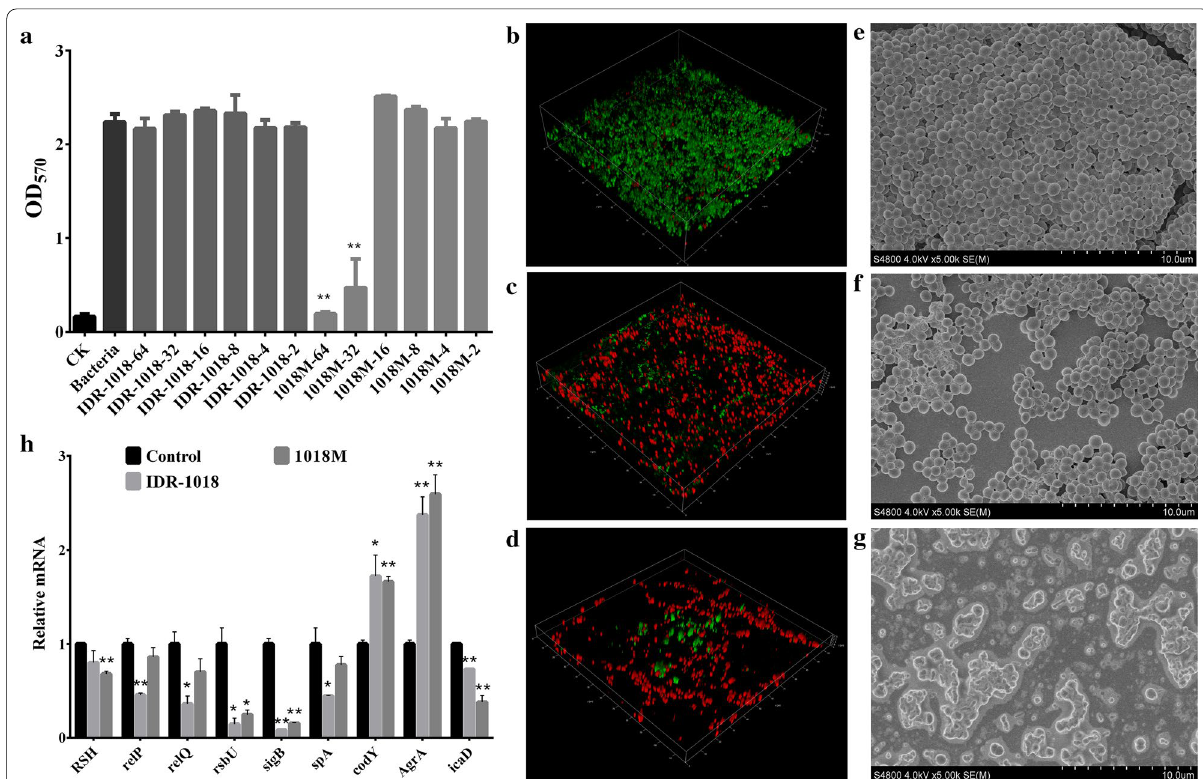
Fig. 5 The abilities of 1018 and 1018M against MRSA biofilms. a Inhibition effect of IDR-1018 and 1018M on biofilms formation. b – d Observation of MRSA ATCC43300 biofilms by CLSM. MRSA ATCC43300 was incubated with 64 μg/mL IDR-1018 ( c ), 1018M ( d ) for 24 h, and biofilms were stained with dyes and visualized by CLSM after removing planktonic bacteria. Live cells are stained in green by SYTO9 and dead cells are stained in red by PI. b The untreated biofilm. e – g Observation of MRSA ATCC43300 biofilms by SEM. e Untreated biofilm, f IDR-1018, g 1018M. h Relative gene expressions of biofilms. MRSA ATCC43300 cells were incubated with 4 MIC peptides or no peptide for 2 h and collected by centrifugation. After × isolation RNA from cells, the transcriptional levels of ppGpp metabolism and biofilm formation related genes were detected by qRT-PCR. All assays were performed in triplicate. The analyses were measured by one-way ANOVA, with Duncan’s multiple comparisons test. A probability value of < 0.05 was considered significant. (*) Indicates the significance between control and each of treatment groups. * p < 0.05; ** p < 0. 01. The results are given as the mean SD (n ± =